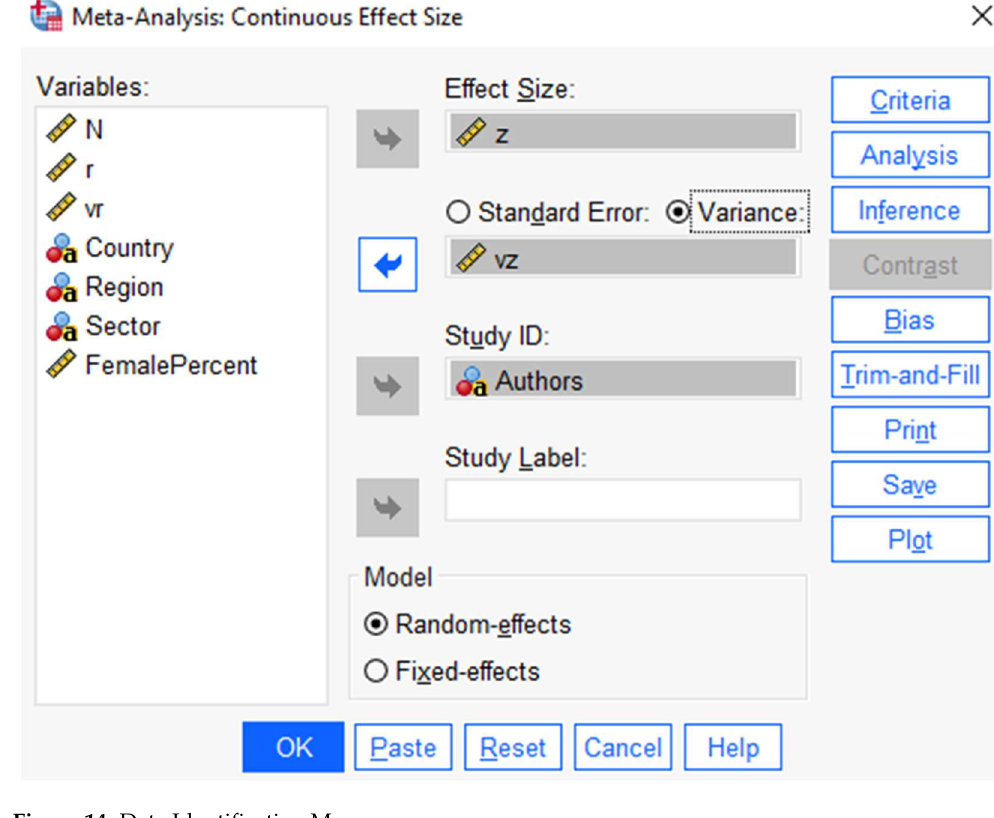
Figure 14. Data Identification Menu.